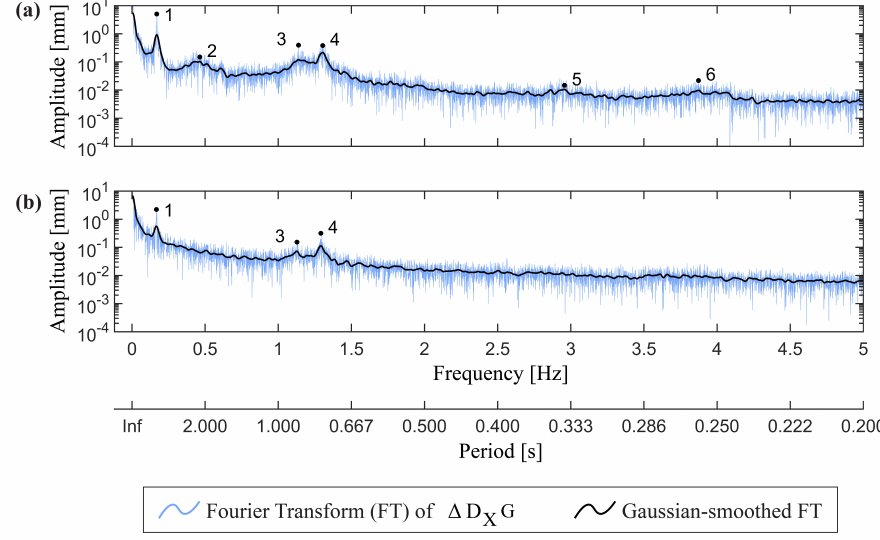
Figure 14. Fourier transform of the tower movement ∆ D derived from ( a ) video camera and ( b ) MIMO-SAR acquisitions for the frequency range between 0 and